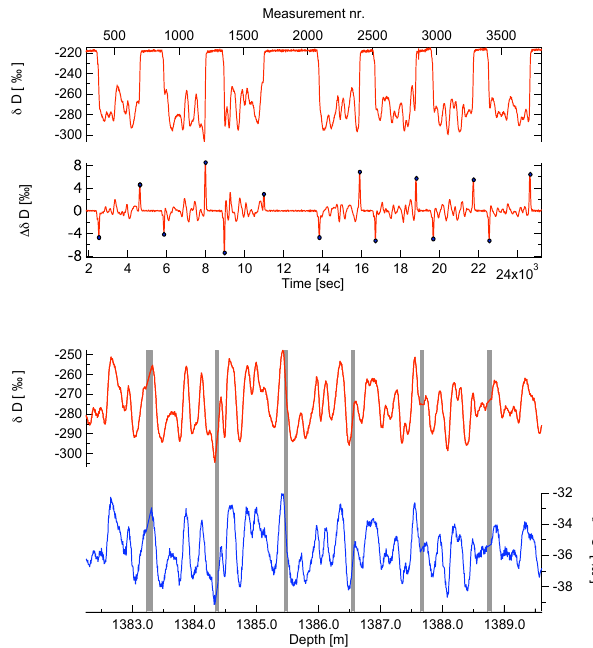
Fig. 4. The beginning and end of each CFA run is determined by the extrema of the 1st derivative of the isotopic signal, presented on the top graph. With gray bars we indicate the position and width of sections with data that are missing due to breaks in the ice, or removed in order to account for the transition from mQ water to sample and vice cersa.